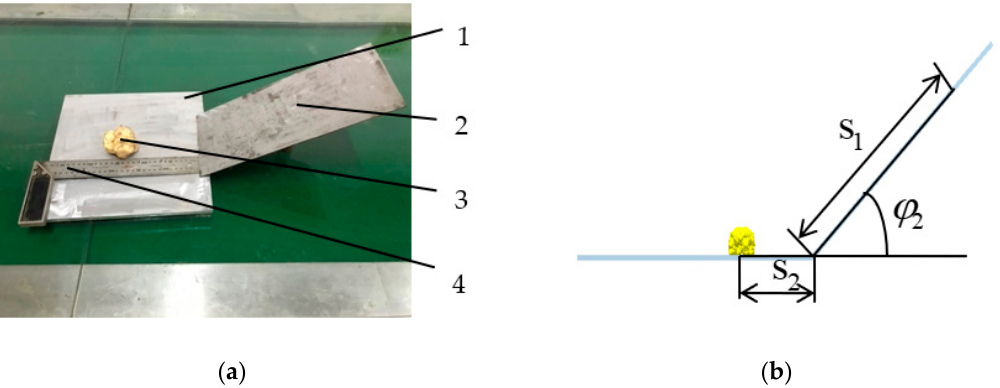
Figure 7. Calibration experiment of rolling friction coefficient. ( a ) Physical experiment; ( b ) Simulation test. 1. Horizontal plane; 2. Inclined plane; 3. Lily bulb; 4. Right angle ruler.